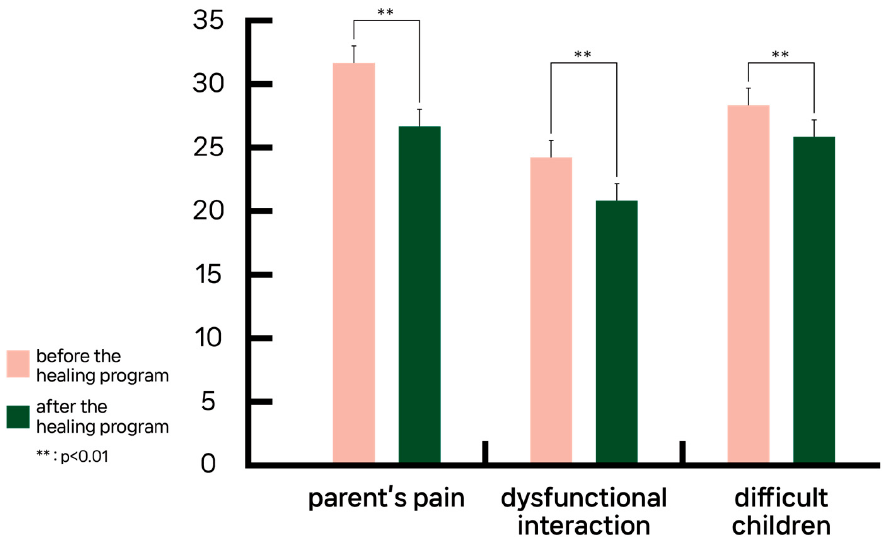
Figure 5. Results of subdomains for K-PSI-SF during 2018–2021.